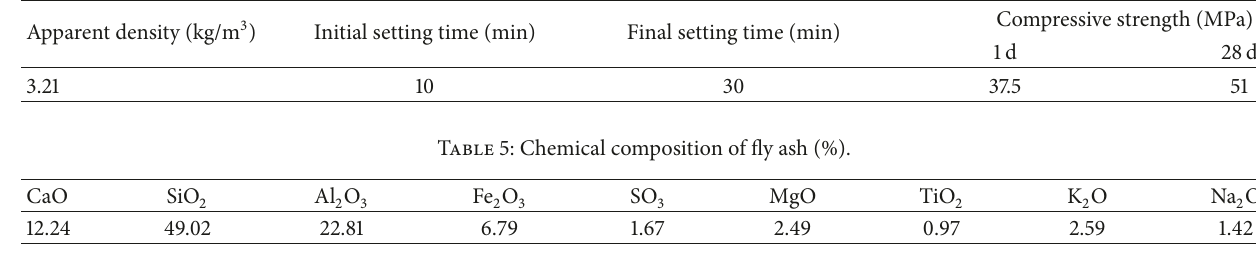
Table 4: Physical parameters of sulphoaluminate cement.